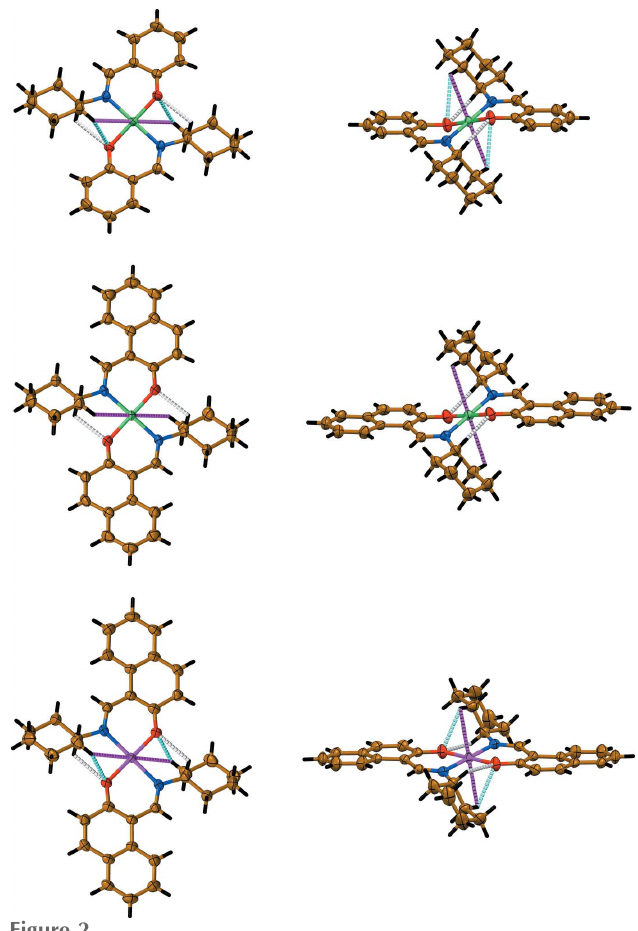
Figure 2 Top and side views of the crystal structures of [Ni( L I ) 2 ] (top row), [Ni( L II ) 2 ] (middle row) and [Cu( L II ) 2 ] (bottom row). Furthermore, 75% atomic displacement ellipsoids are shown for non-hydrogen atoms. Colour code: H = black, C = gold, N = blue, O = red, M = green or magenta, an M (cid:2)(cid:2)(cid:2) H anagostic bond = magenta dashed line, an O (cid:2)(cid:2)(cid:2) H interaction = grey dashed line and an O (cid:2)(cid:2)(cid:2) H elongated interaction = cyan dashed line . The crystal structure of [Cu( L I ) 2 ] is very similar to that of [Ni( L I ) 2